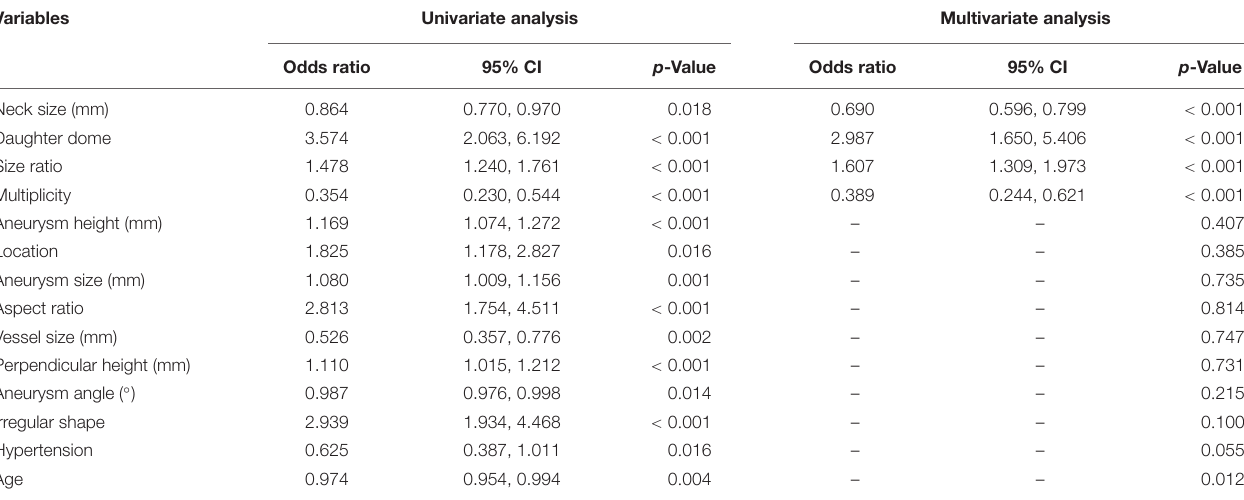
TABLE 2 | Univariate and multivariable analysis of morphological and clinical features associated with aneurysm